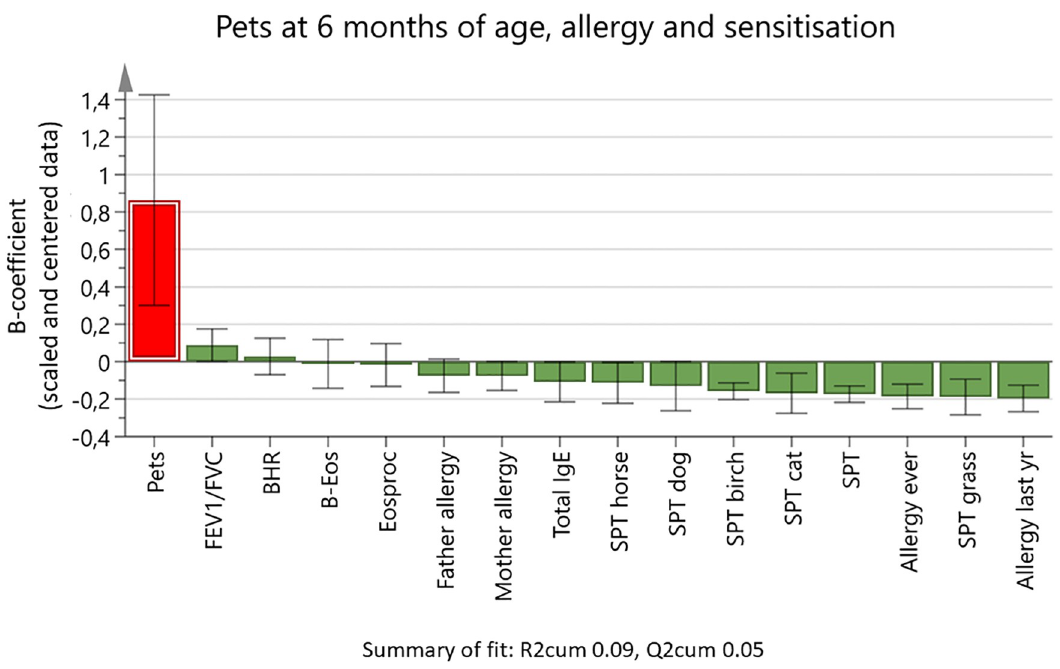
Fig 3. Orthogonal projection to latent structures loading plot showing associations between the number of household cats and dogs when the child was 6 months old (Y variable), and a set of 15 X variables. The outcome variables for lung function (forced expiratory volume in 1 s [FEV 1 ]/forced vital capacity [FVC]), bronchial hyperresponsiveness (BHR), blood eosinophil count (B-Eos), percentage of blood eosinophils (Eosproc), total immunoglobulin (IgE), and skin-prick tests (SPTs) were from the age 8–9 years follow-up. SPTs are given as weal diameter. X variable bars pointing in the same direction as the Y variable are positively associated with the Y variable, and bars pointing in the opposite direction are negatively associated. The height of the bars shows the B- coefficients for scaled and centered data, with 95% confidence